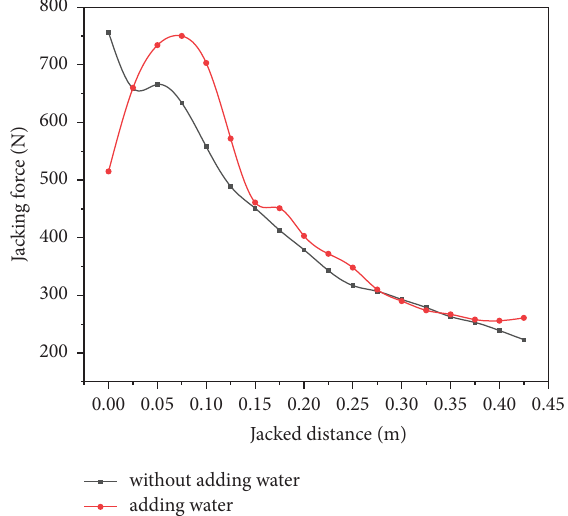
Figure 13: Infuence of water conditions on jacking